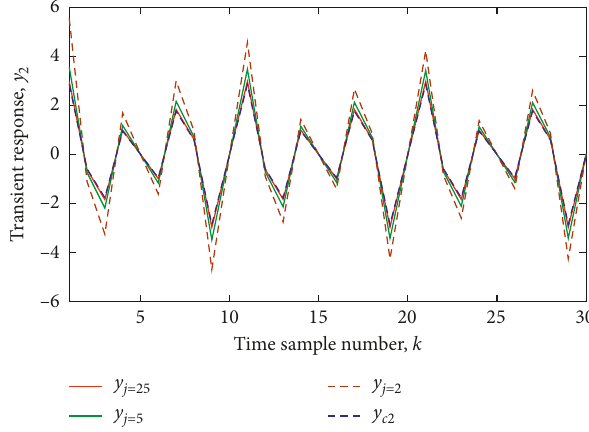
Figure 2: Outputs y 1 at the 2nd, 5th, and 25th